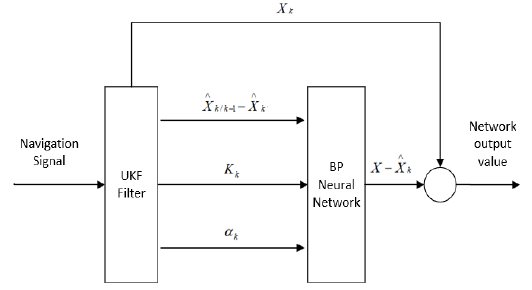
Figure 3 . Principle diagram of BP neural network modified UKF algorithm.